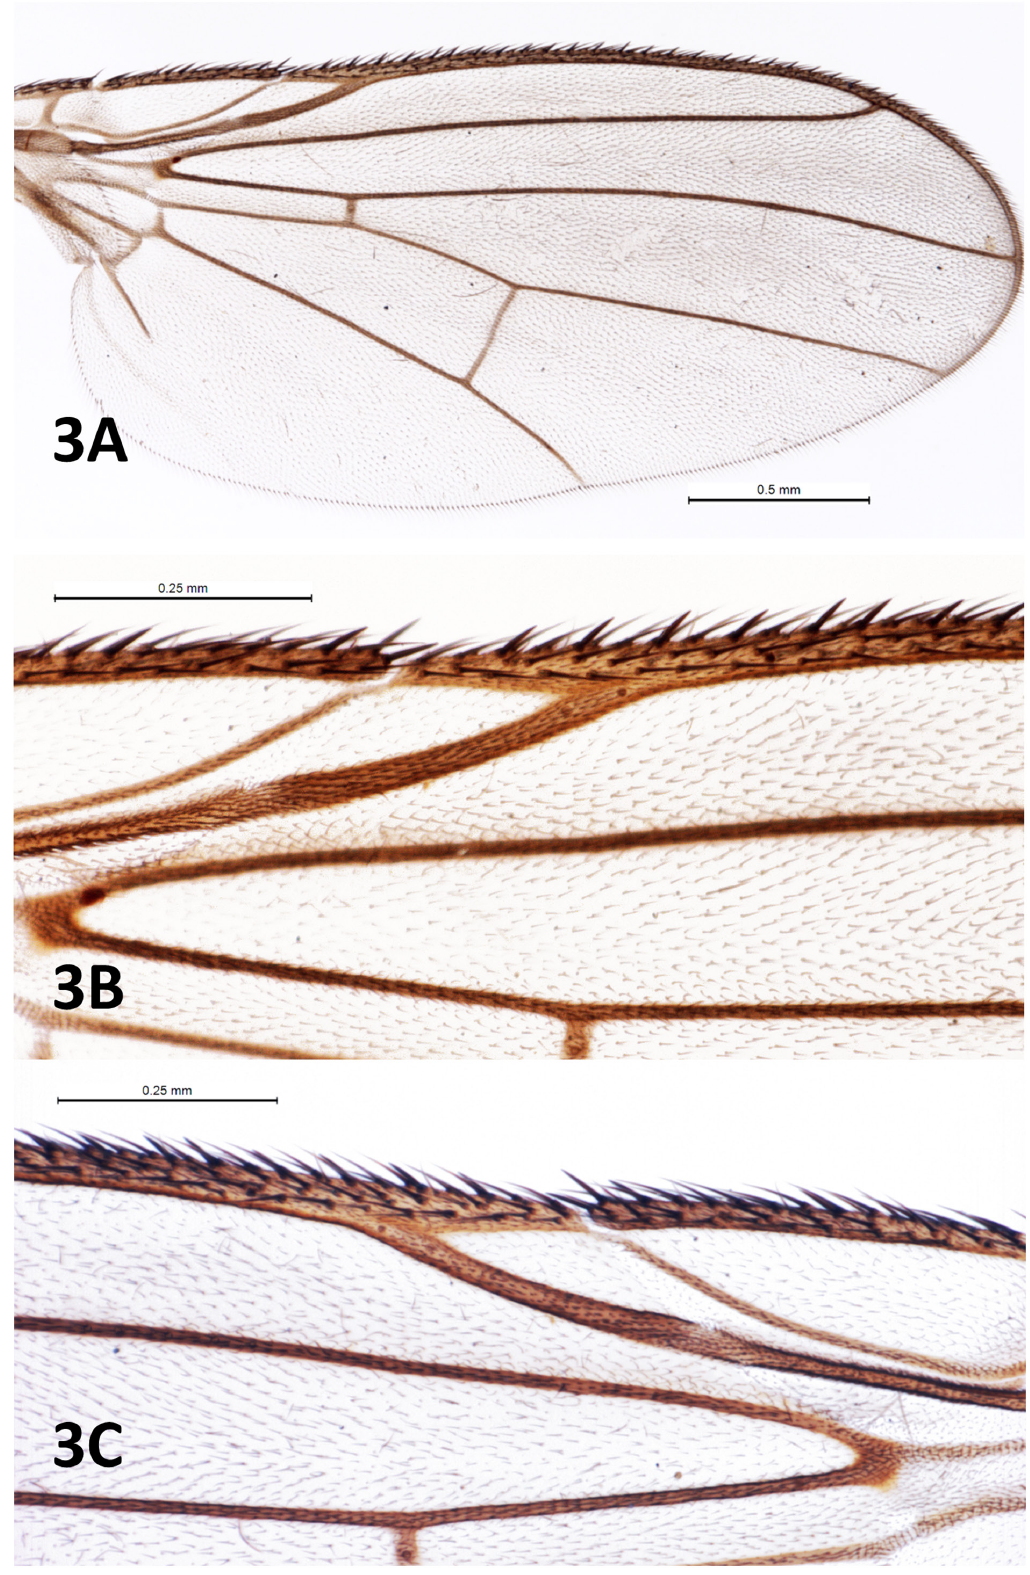
Fig. 3. Australofannia spiniclunis Pont, 1977, ♀. A . Wing, ventral view. B . Detail of wing showing CS1‒3, ventral view. C . Detail of wing showing CS1‒3, dorsal